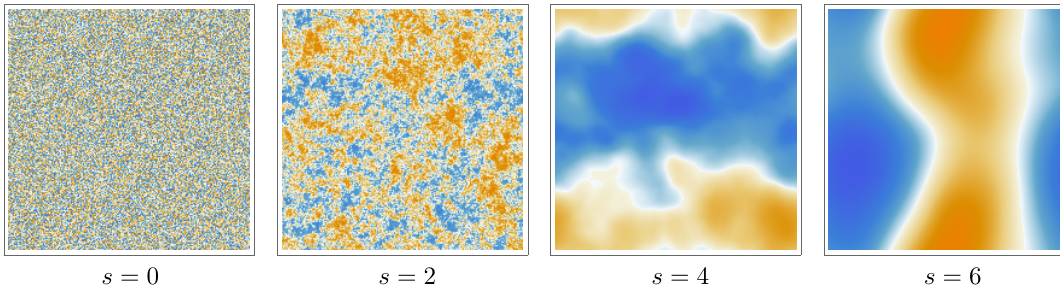
Figure 1 . Random cosmological samples of dS 3+1 higher spin (cid:12)eld modes (cid:12) of spin s = 0 ; 2 ; 4 ; 6 in position space. Drawn from Gaussian distribution with power spectrum D (cid:0) s + 1 2 (cid:24) k (cid:0) 2 s +1 where D is the discrete Laplacian on a 3d torus of linear size L , with lattice spacing L lattice points), with the zero mode IR-regulated by adding a mass term of order 1